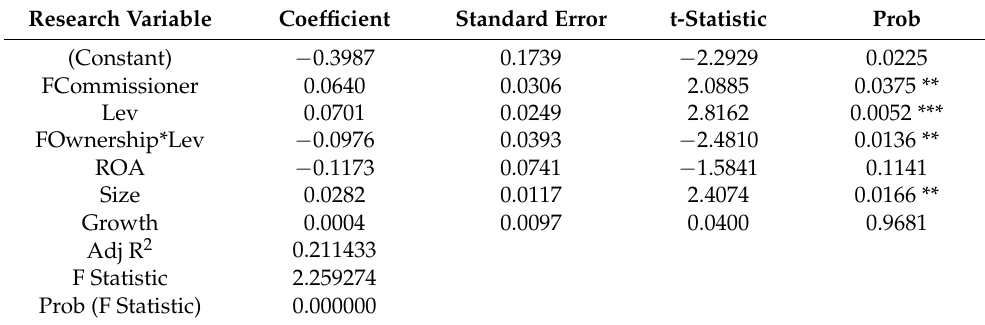
Table 5. Family Members on the Board of Commissioners and Earnings